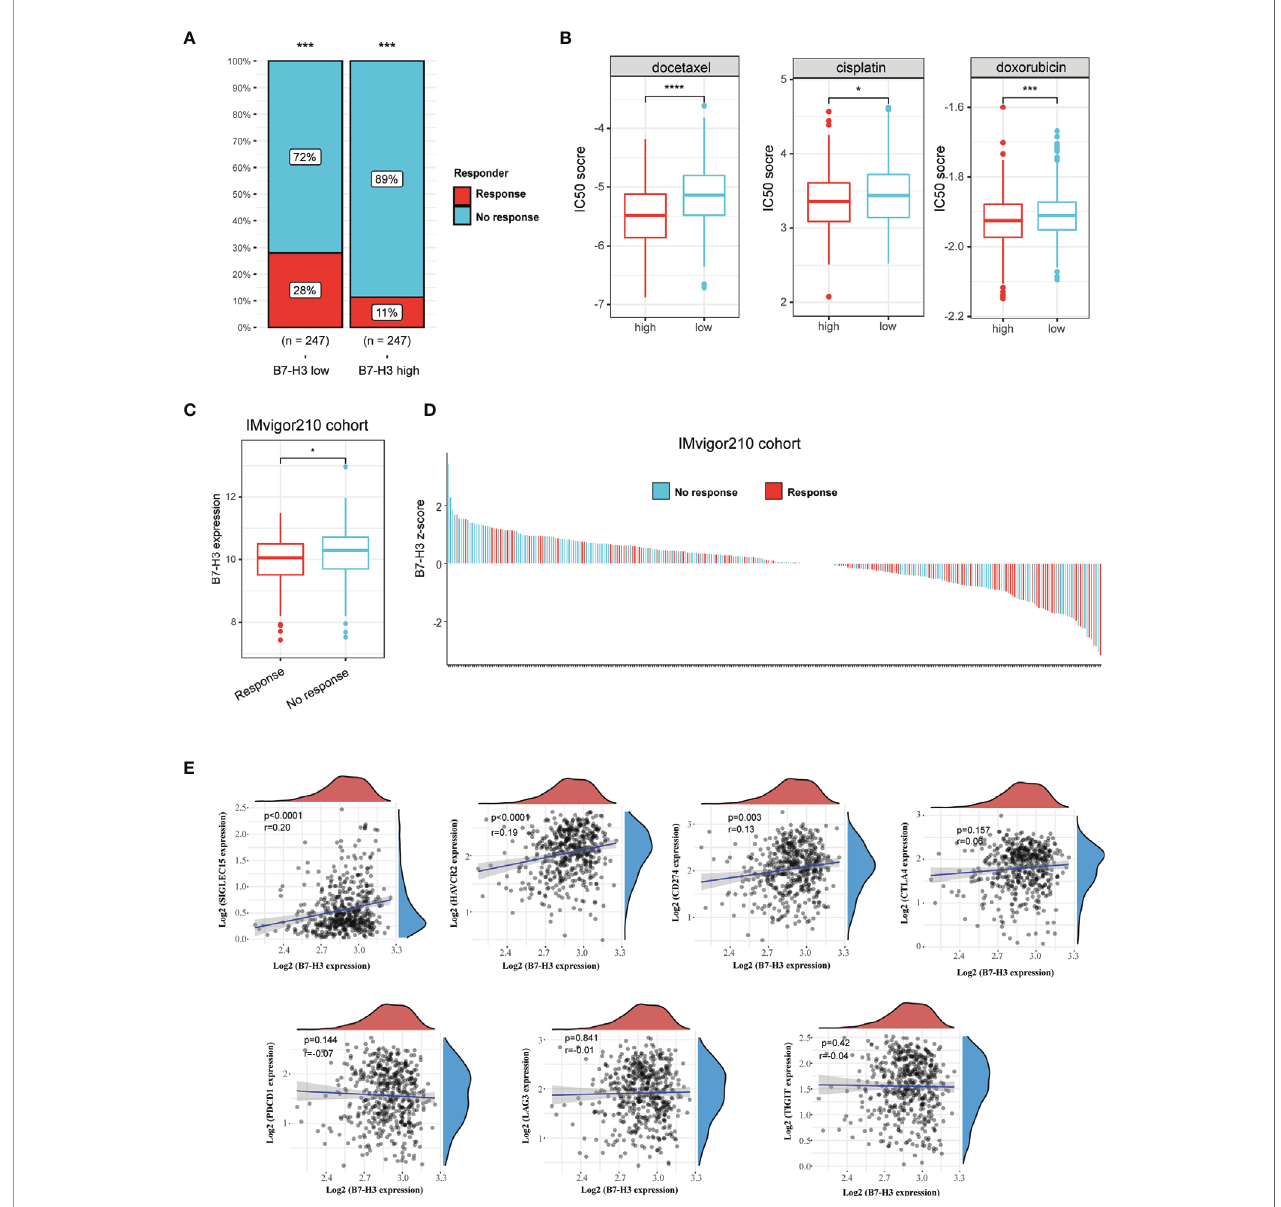
FIGURE 4 | B7-H3 serves as a biomarker that predicts the response of immunotherapy. (A) Bar plot presents response rate of immunotherapy between high and low B7-H3 expression; (B) Predictive IC50 scores of docetaxel, cisplatin, and doxorubicin between high and low B7-H3 expression; (C) Box plot shows the differential B7-H3 expression between response and no response patients treat with ICB therapy in IMvigor210 cohort; (D) Waterfall plot depicts the B7-H3 expression (z-score) for a response as well as no response patients in IMvigor210 cohort. (E) Scatter plot shows the correlation between B7-H3 and immune checkpoint. *P < 0.05, ***P < 0.001, & ****P <